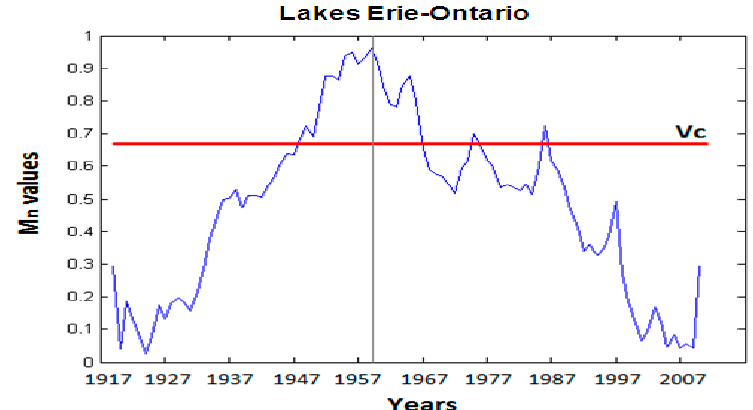
Figure 7. Analysis of dependence using the copula method. Temporal variability of M n values derived for monthly mean minimum water level series for Lakes Michigan ‐ Huron and Erie (1918–2012). The horizontal red line shows the critical value of V c . The vertical line represents the timing of the change of dependence between the water levels.